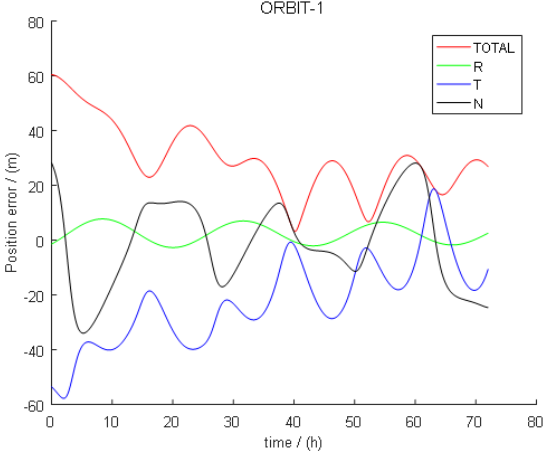
Figure 7. Position error of ORB-1 determined using 3 days of ground- based radar data, assuming no errors in dynamic model